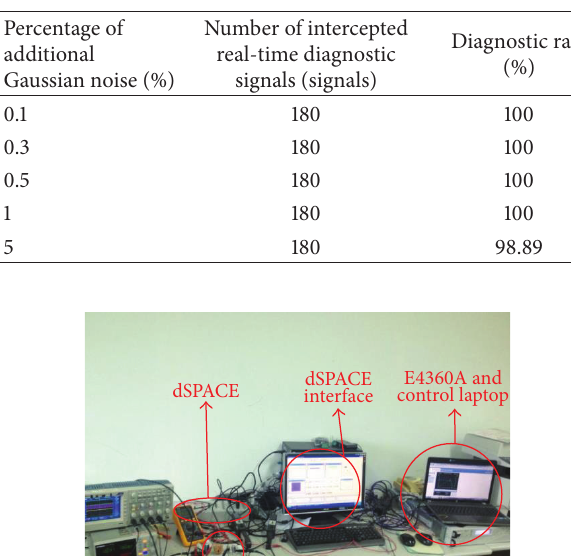
Table 5: Real-time diagnosis rate.